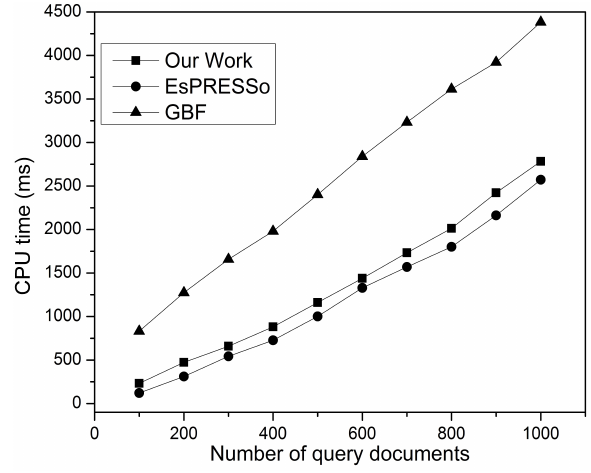
Figure 15. Performance query